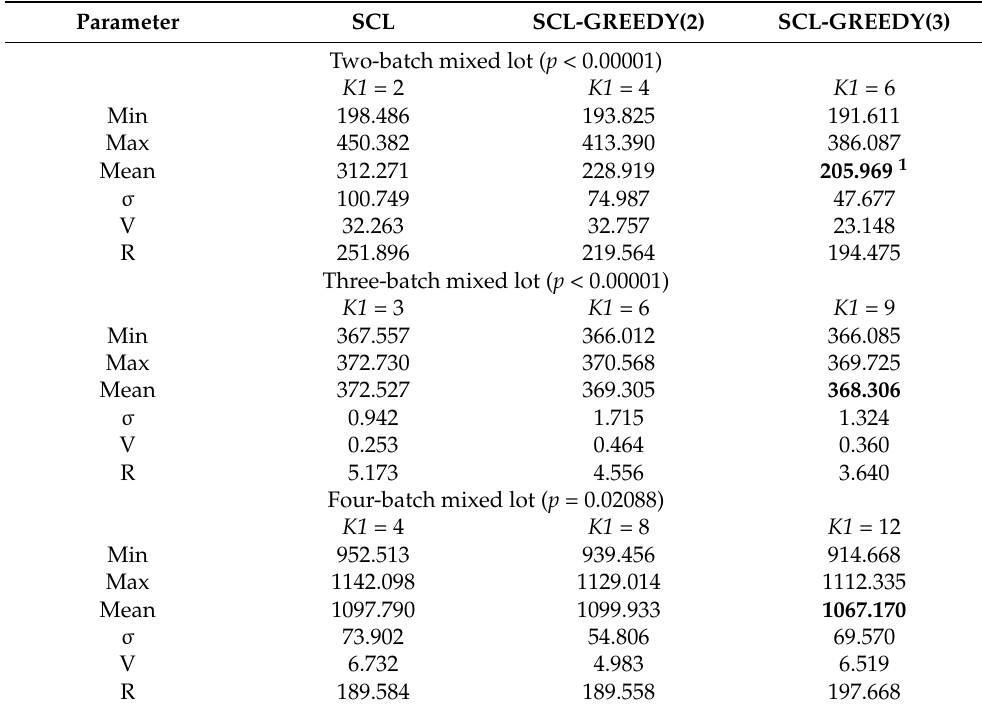
Table 3. Objective function value summarized after 30 attempts (squared Euclidean